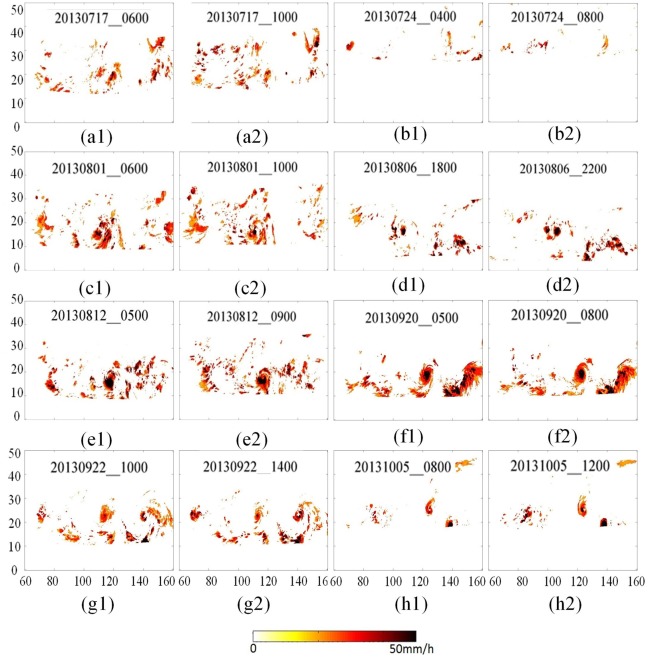
Estimated precipitation of Fengyun-2F (FY-2F) at representative times for the 8 periods studied.(a-h) are precipitation imageries of T1, T2… and T8 which are the same as in Table 1. Δt =4 hours, and the spatial resolution is 0.1°×0.1°.